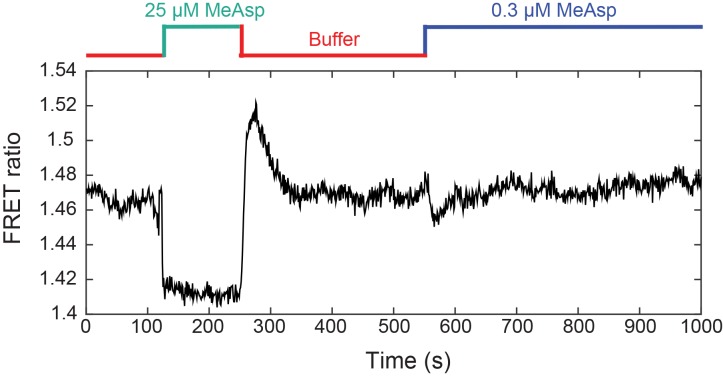
Example of FRET measurement used for the evaluation of g+(t).A CheR+ CheB+ strain expressing TarQEQE as sole receptor and the CheY-YFP/CheZ-CFP FRET pair, equilibrated in buffer (red), was briefly stimulated with a saturating amount of MeAsp (25 µM; green) to evaluate the FRET ratio at zero activity, re-equilibrated in buffer, and then stimulated with a subsaturating amount of MeAsp (0.3 µM; blue). The FRET ratio was measured on an area of confluent cells. Normalized responses to 0.3 µM MeAsp from five independent replicates of this experiment were averaged to compute the step response function of Figure 4A.